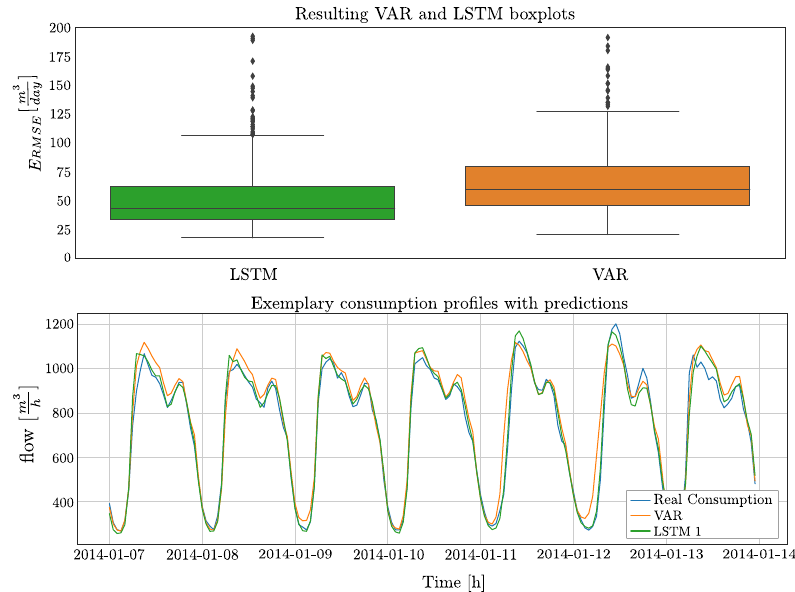
Figure 7. Upper plot: Resulting boxplots when performing batch learning using a VAR and LSTM model. Lower plot: Exemplary predicted daily profiles for water consumption profiles for one